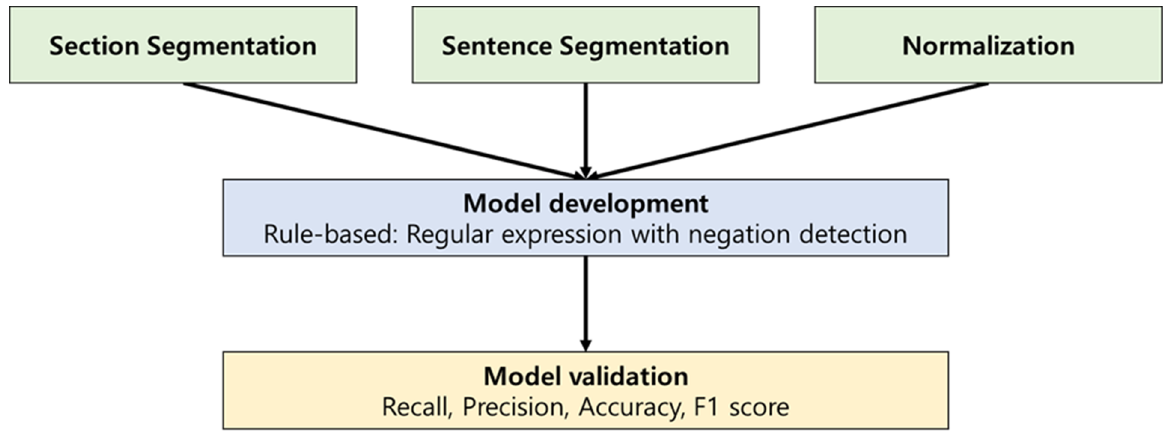
Figure 1. Summary of the natural language processing pipeline.